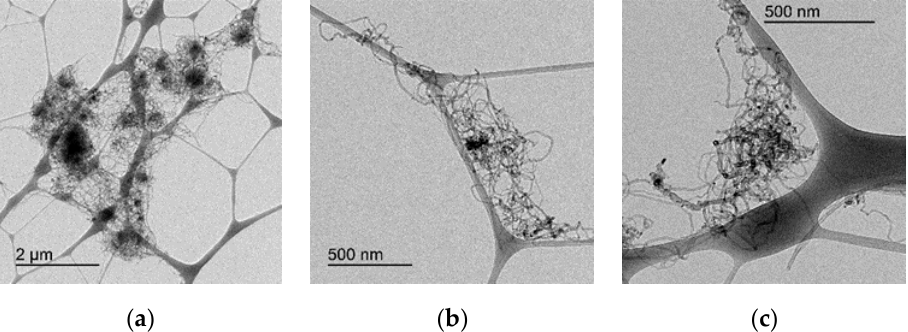
Figure 4. a–c: TEM micrographs of original CNTs at different magnification scale.